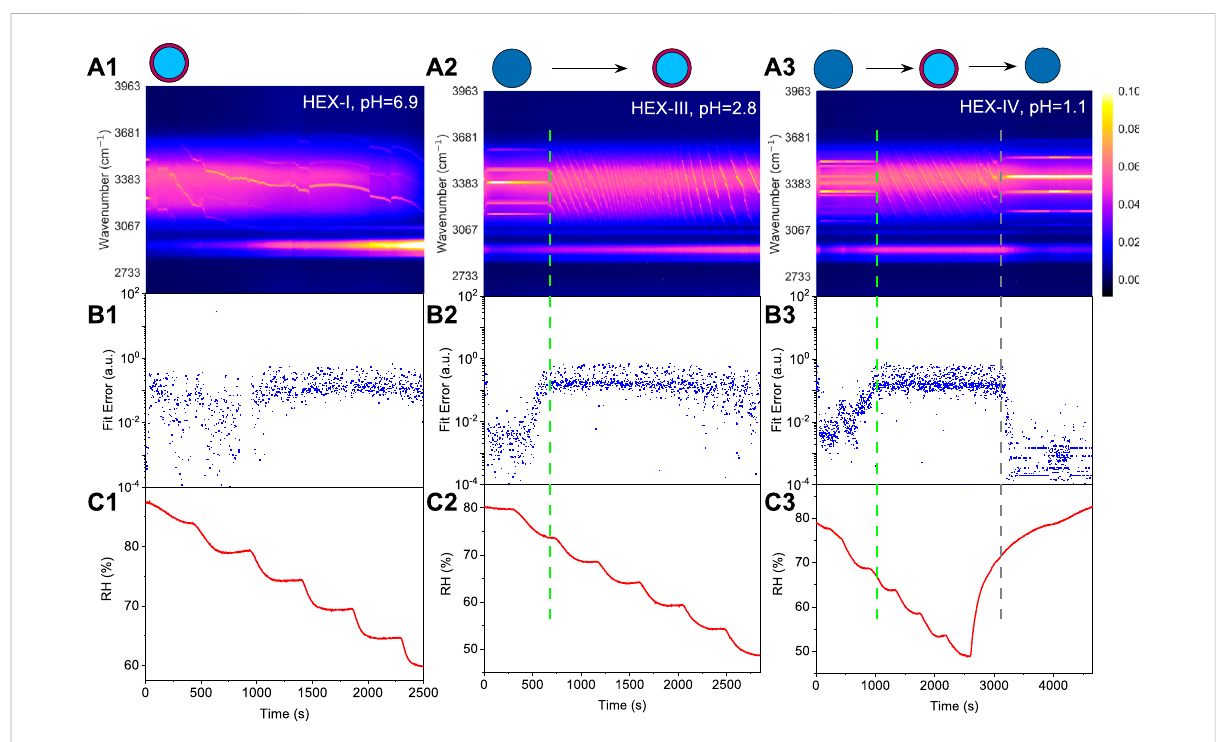
FIGURE 5 Liquid-liquid phase separation of 1,2,6-hexanetriol/ammonium sulfate/water. Top row: time-resolved Raman spectra and schematic diagrams of phase separation, the bright trend dots indicate the position evolution of the peaks. Middle row: fi tting errors of the WGMs based on the homogenous Mie scattering model. Bottom row: RH variation with time in the trapping chamber during humidity steps. Panels (A1 – C1) : aerosol generatedfromSolutionHEX-I.Panels (A2 – C2) :aerosolgeneratedfromSolutionHEX-III,greendashedlineindicatesthemomentwhenphase separation occurred. Panels (A3 – C3) : aerosol generated from Solution HEX-IV, green dashed line and grey dashed line indicate the moment when phase separation and phase mixing occurred, respectively. Results of HEX-II (pH = 4.8) can be seen in Supplementary Figure S2 in the Supplemental